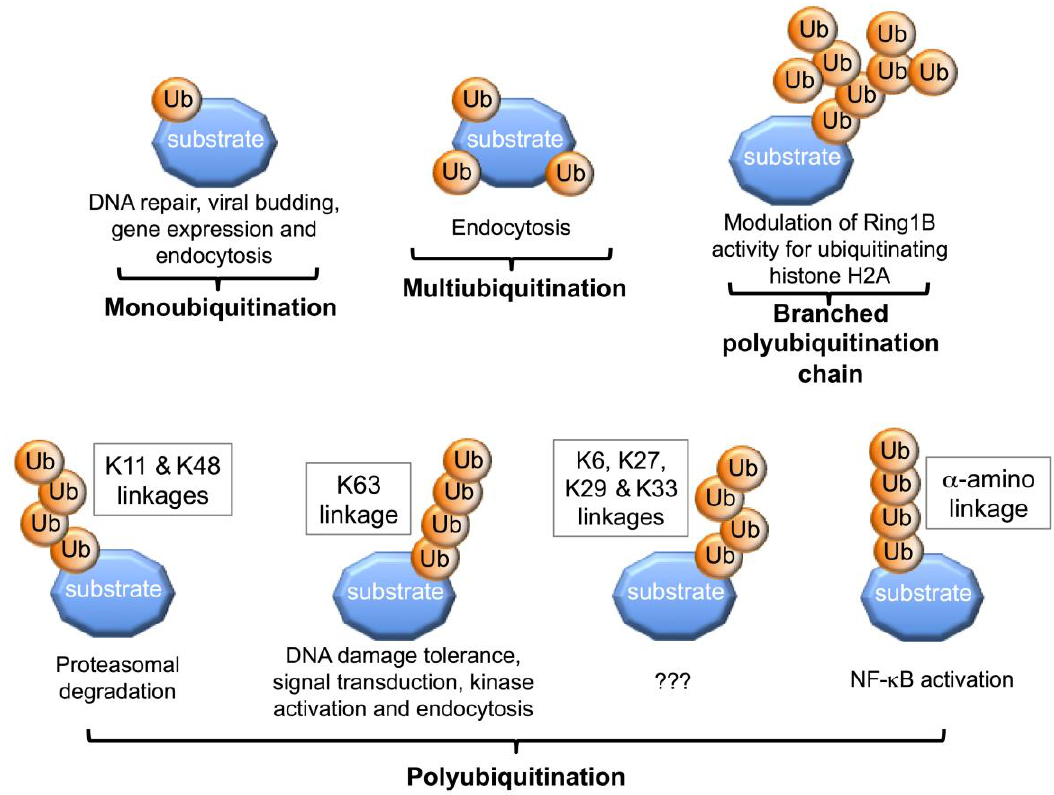
Figure 1. Generation of different Ub structures leads to different protein